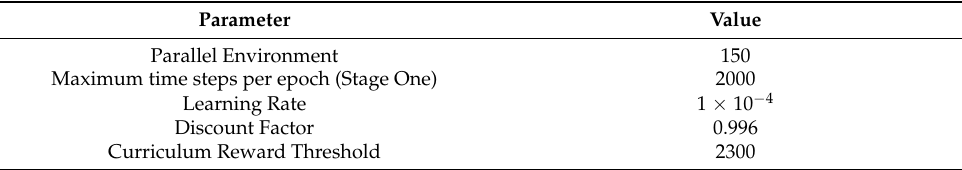
Table A3. Training Hyper Parameters.